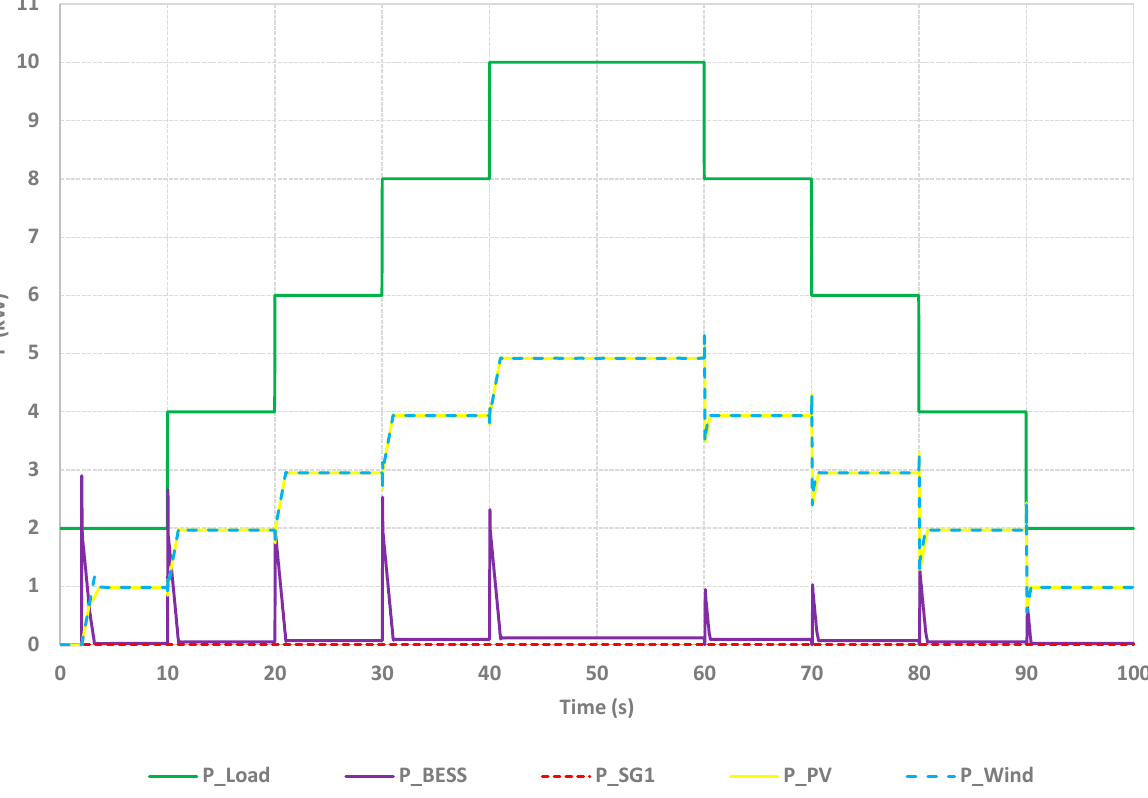
Figure 11. Scenario 1: Variable demand curve and maximum solar PV and wind generation with battery energy storage system (BESS).